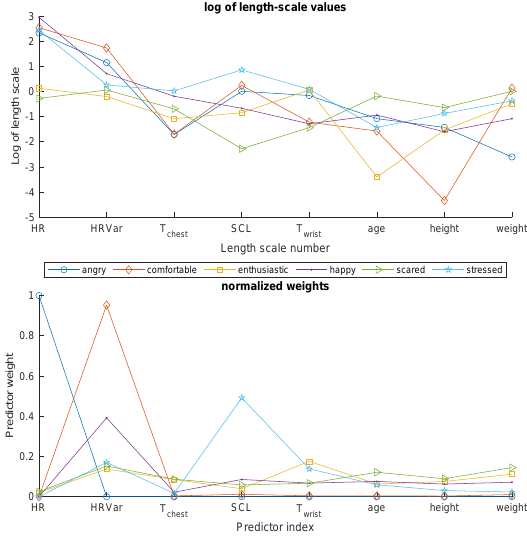
Figure 4. SE length scale parameters (log values) and parameter weights with SCL parameter. Note that for values smaller zero, the absolute value of l was used. This applies to the following figures of this type.